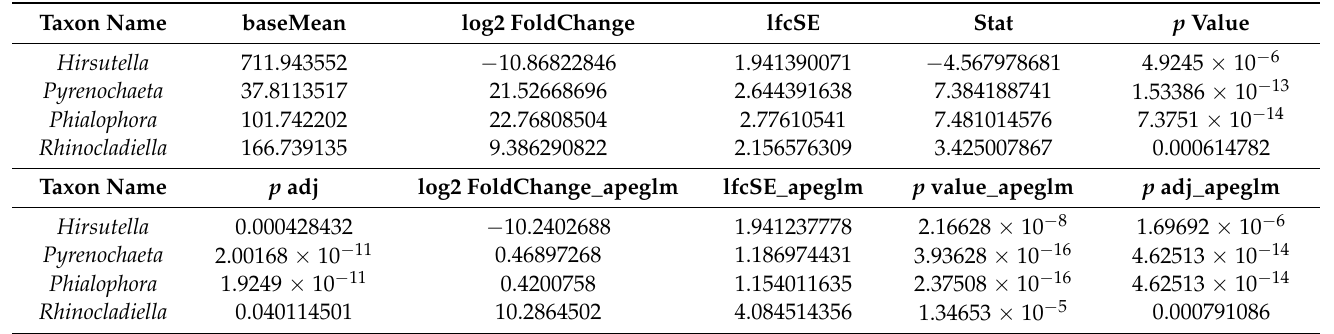
Table 4. Differential abundance analysis of statistically significant species according to the origin of the